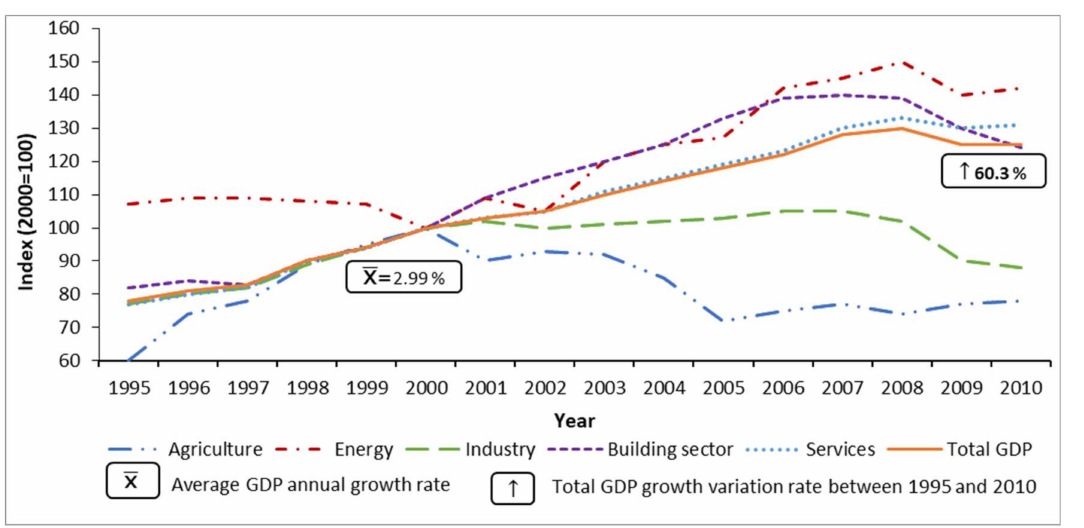
Figure 2. Total Gross Domestic Product (GDP) growth and sectorial evolution, total GDP growth variation rate between the sixteen analysed years and average GDP annual growth rate in Spanish Tagus Basin (1995–2010), chained indexes (2000 = 100)